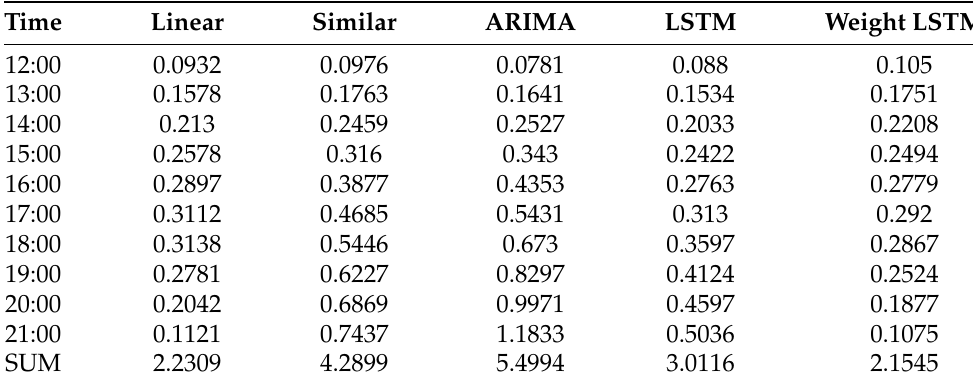
Table 10. Mean absolute error (MAE) for all